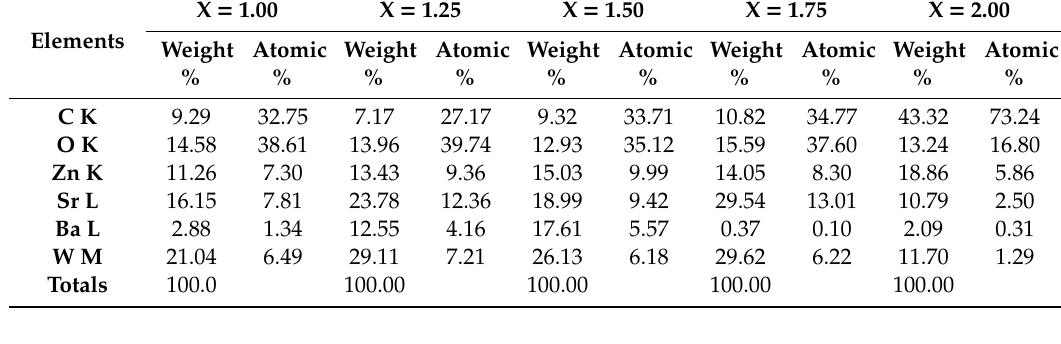
Figure 4. ( a – e ) SEM images of Ba 2 − x Sr x ZnWO 6 (x= 1, 1.25, 1.50, 1.75, 2) double perovskite series samples.